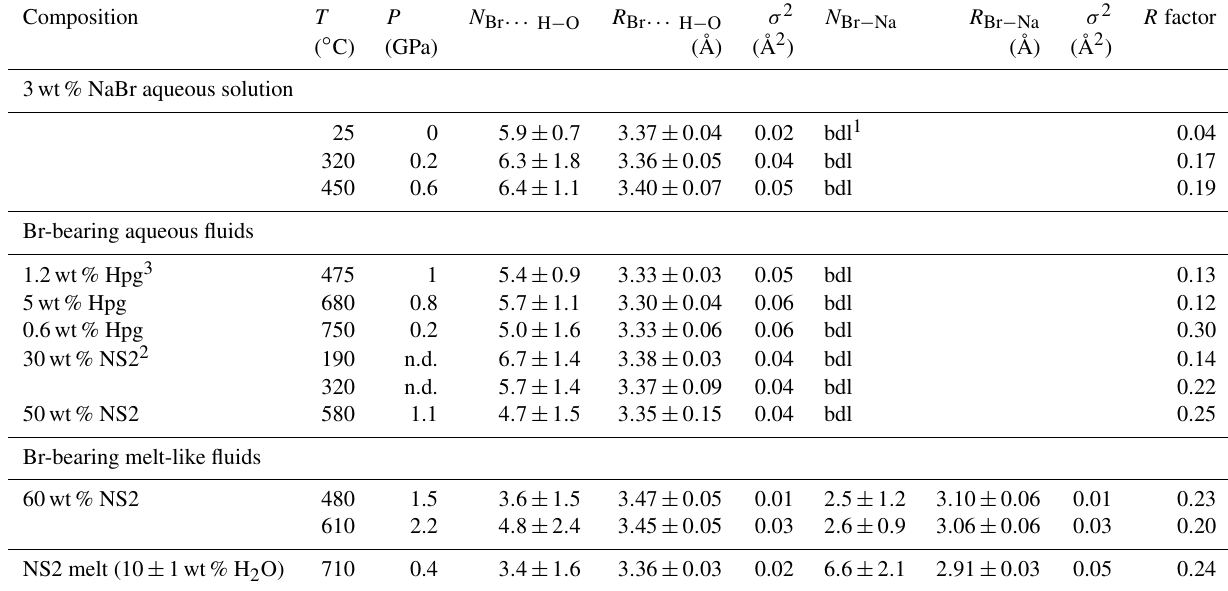
Table 4. Br K-edge EXAFS analysis of experimental high P – T fluids with various compositions.